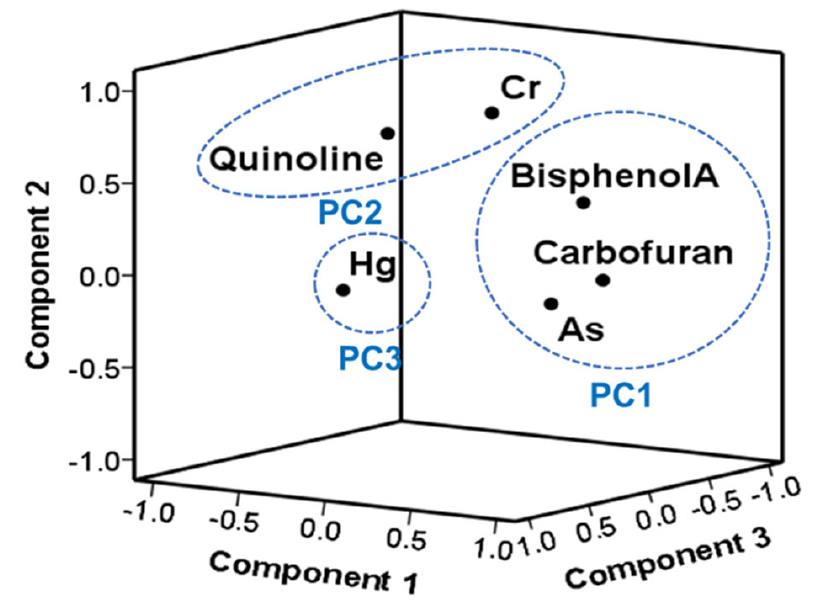
Figure 5. Component plot in rotated space of the Han River watershed.